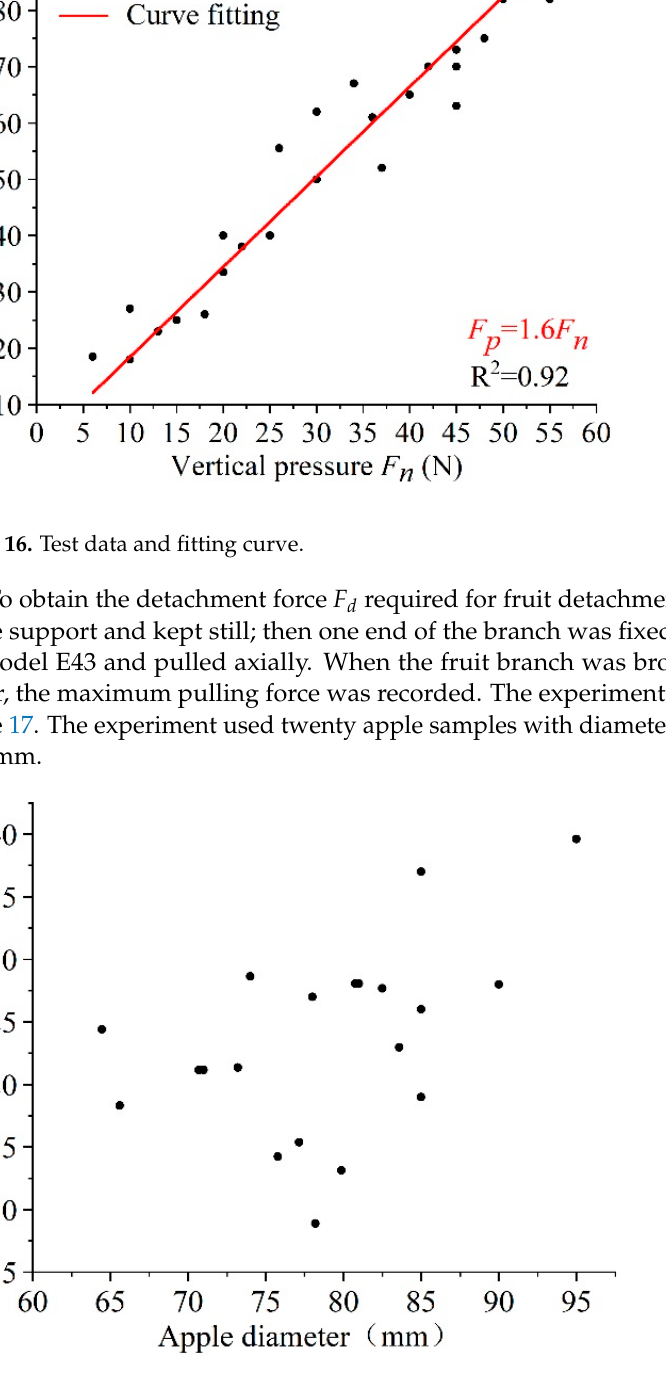
Figure 17. The influence of apple diameter on detachment force.